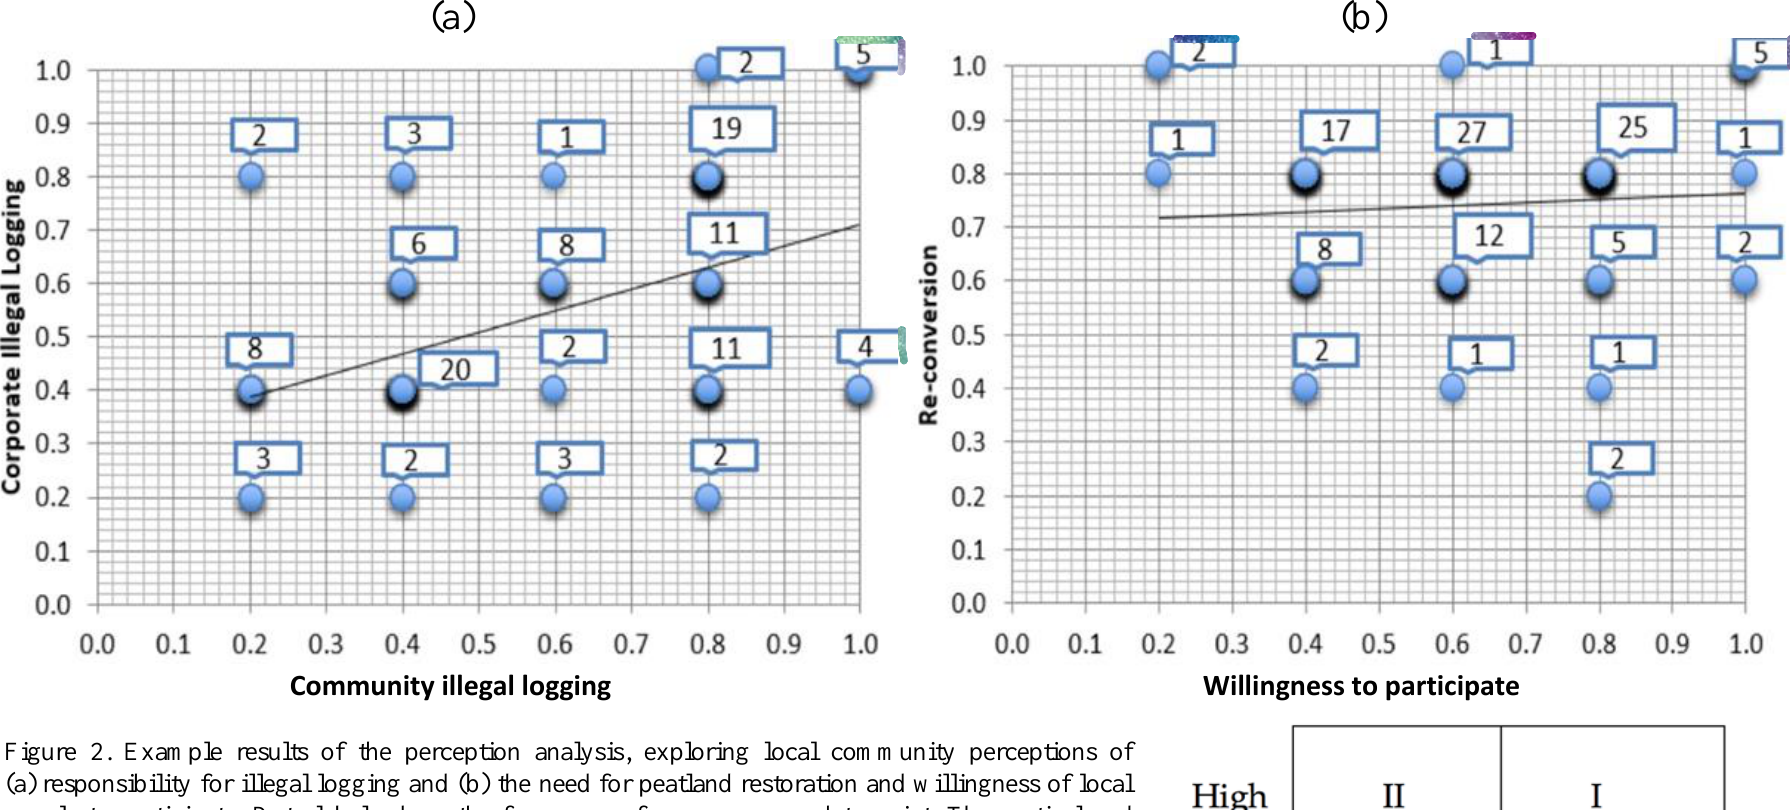
Figure 2. Example results of the perception analysis, exploring local community perceptions of (a) responsibility for illegal logging and (b) the need for peatland restoration and willingness of local people to participate. Data labels show the frequency of responses per data point. The vertical and horizontal axis values range from 0.2 to 1.0, indicating standardised (indexed) responses (= Likert score ÷ maximum score). For example, a value of 0.2 indicates the response of 1 (Likert score) divided by the maximum score of 5, i.e. 1/5 = 0.2, and so on. The inset (right) shows how the co-ordinate plane is divided for the forced choice procedure. Positive trendline (Fig 2.a and b) indicates a shift from lower value of perception to a higher value of